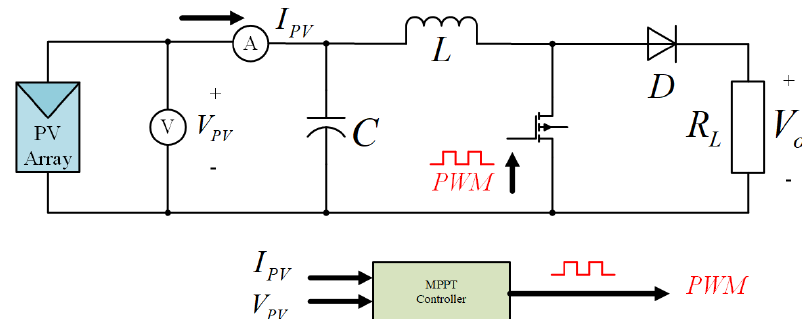
Figure 8. Basic PV system with DC–DC boost